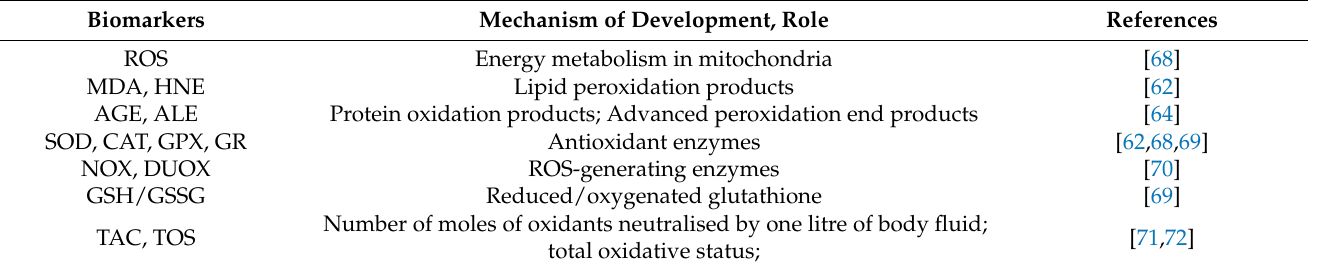
Table 1. Biomarkers of oxidative stress used in thyroid disease research